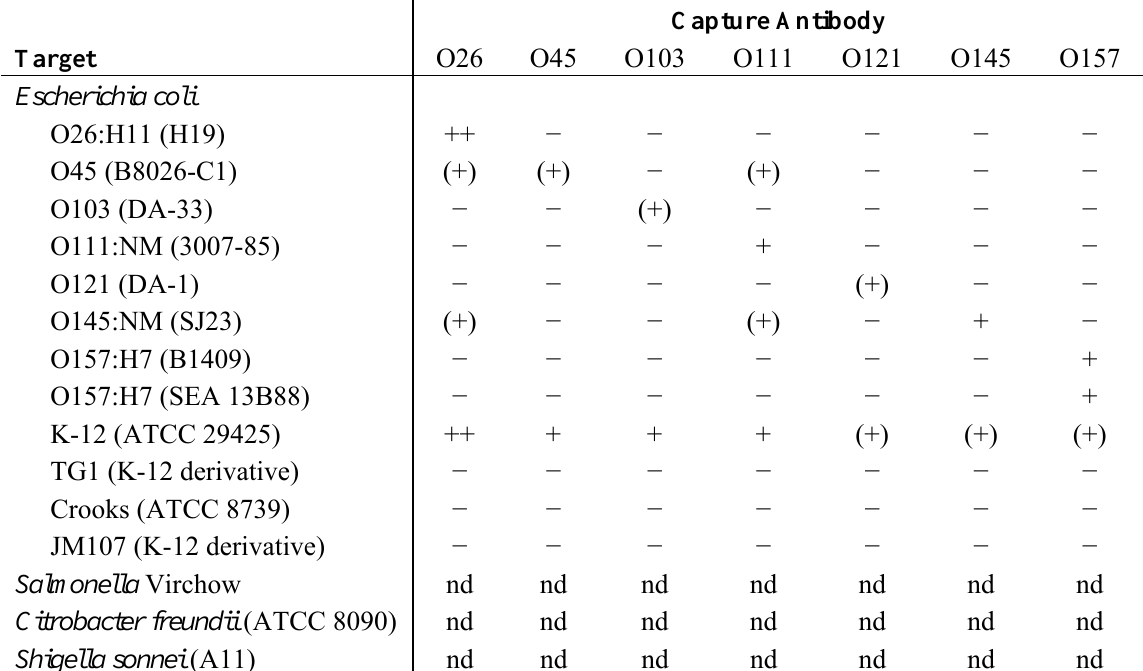
Table 3. Semi-quantitative microarray responses for target and non-target bacterial samples ( ca. 1 × 10 8 CFU/mL) reacted with high dilutions (1:100 to 1:500) of KPL purified IgGs. (Key: − = no binding; (+) = faint binding; + = binding; ++ = high binding, nd = not